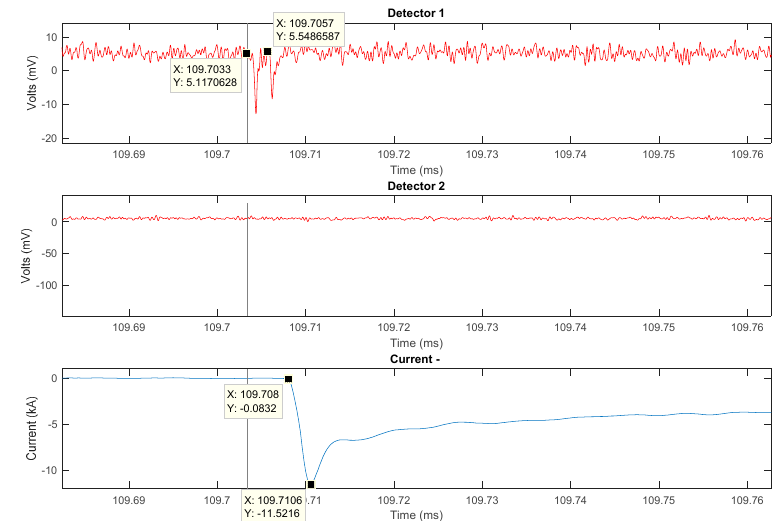
Figure 8. X-rays from a subsequent stroke of another flash occurred on 02 March, 2015. Time (ms) starting from 20:56:29.879192 UTC is given in the x-axis. Two distinct X-ray peaks are visible in the un-attenuated detector. The occurrence of first (also marked in the black vertical cursor) and second X-ray pulses are about 4.7 and 2.3 µ s prior to the onset of the current peak of the only RS. Because of the limited bandwidth of the fibre-optic link, and electromagnetic interference, the shape of the peaks could also be distorted. The vertical cursor is fixed at the first X-ray peak. The flash contained 17 ICC pulses before this RS. Peak energy of the burst is around 70 keV (calculated by multiplying the peak voltage by the calibration factor). The timestamp of the RS is 20:56:29.988903 UTC.